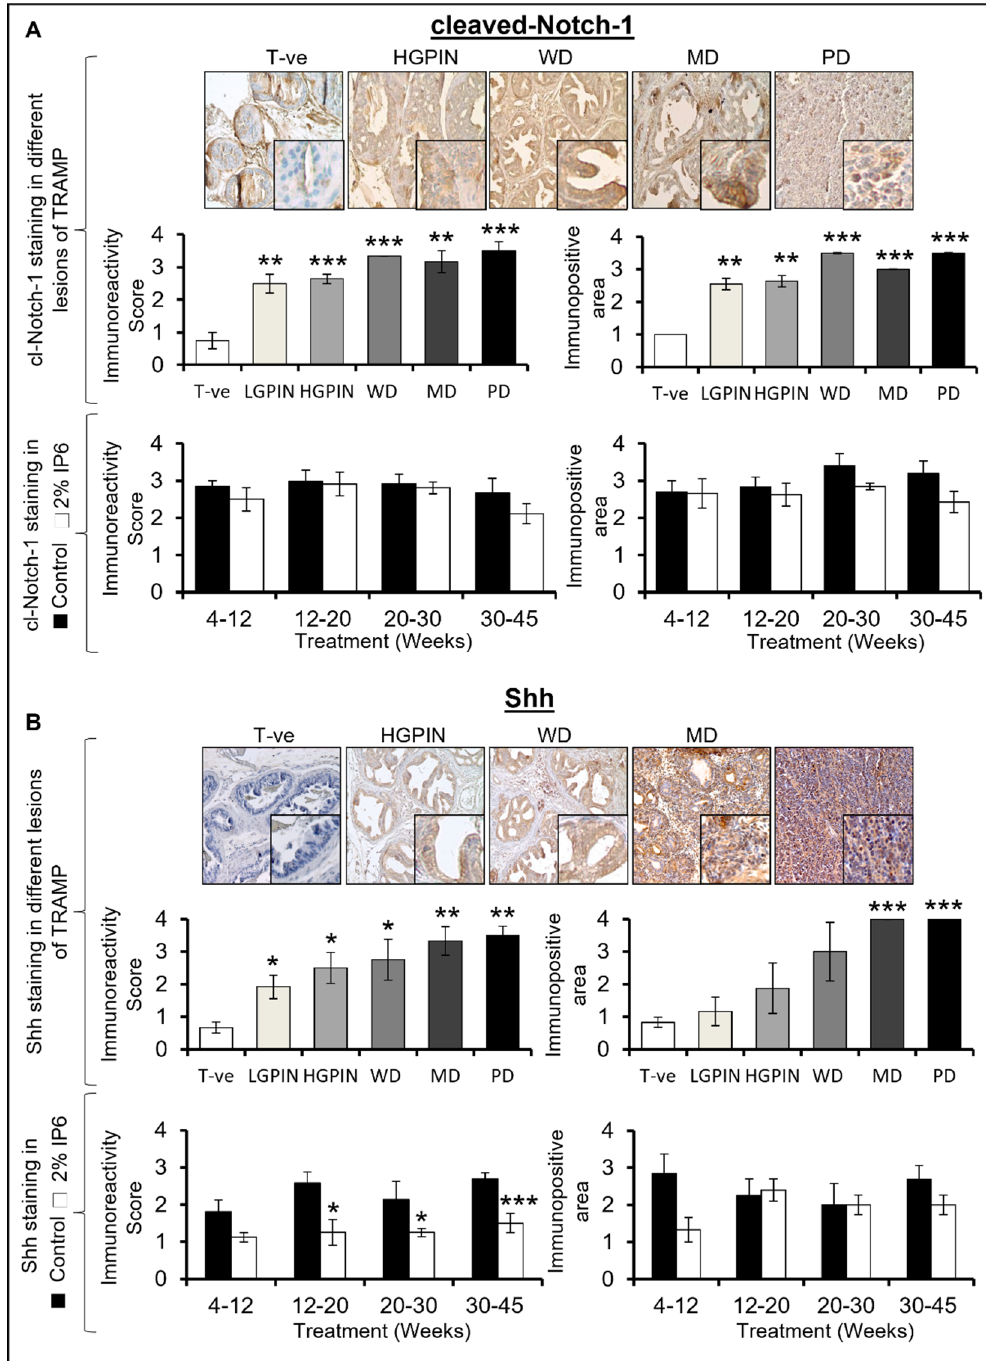
Figure 7. Stage specific effect of IP6 feeding on the expression of CSC-associated signaling molecules in the dorsolateral prostate of TRAMP mice. Pictographs and bar graphs representing the stage- specific expression of CSC-associated signaling molecules ( A ) cleaved-Notch-1, and ( B ) Shh, in WT control (T-ve), TRAMP control, and IP6-fed mice. Representative pictographs are depicted at ×100 magnification and insets represent digital magnifications. Immunoreactivity was scored as 0 (no staining), +1 (weak), +2 (moderate), +3 (strong), and +4 (very strong). The proportion area of prostate (positive for expression) was quantified as immunopositive area score and assigned arbitrary scores as 0 (<5% area), +1 (5–25% area), +2 (26–50% area), +3 (51–75% area), and +4 (>75% area). Quantified data are represented as mean ± SEM. *** p ≤ 0.001, ** p ≤ 0.01, and * p ≤ 0.05 .